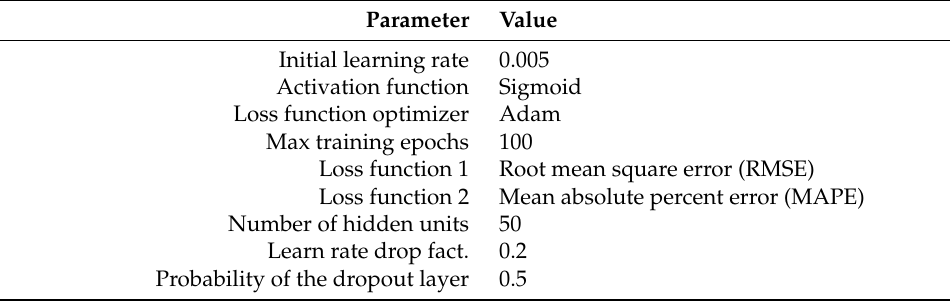
Table 3. Parameters of the built LSTM